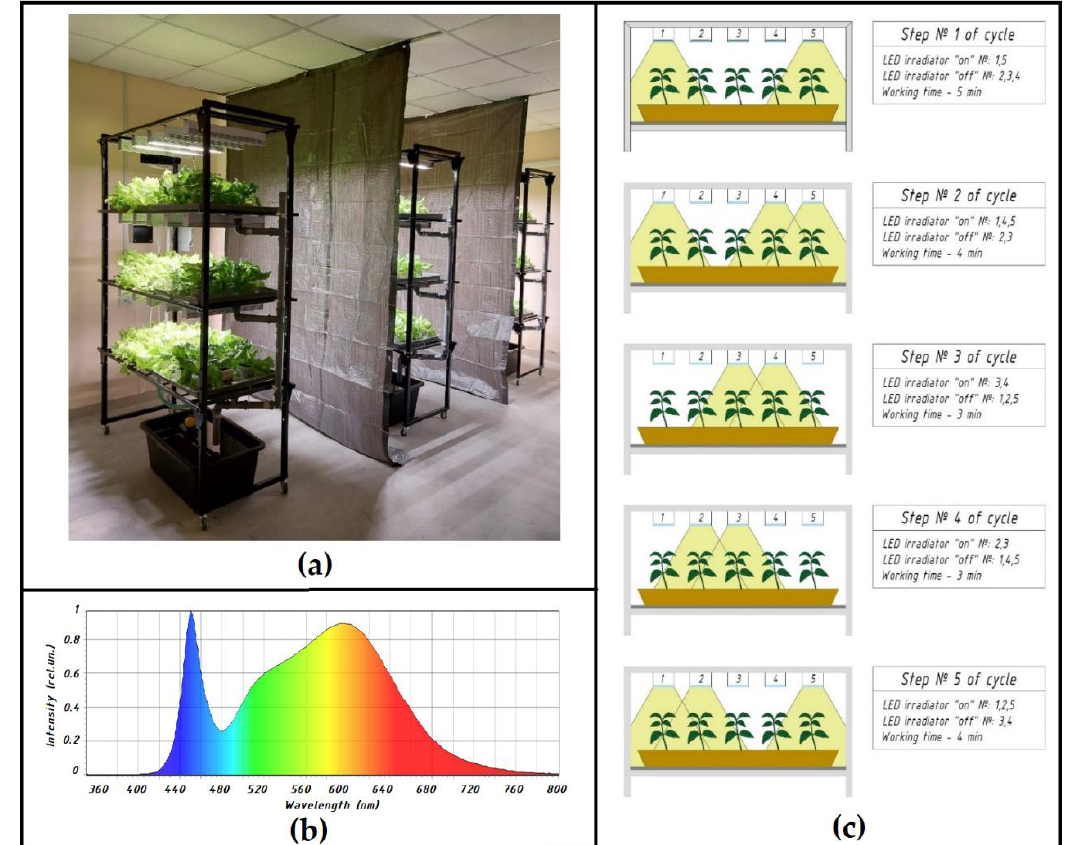
Figure 1. Climatic chamber with plants ( a ), the spectral composition of phytoirradiators radiation ( b ), operating parameters of scanning irradiation ( c ).